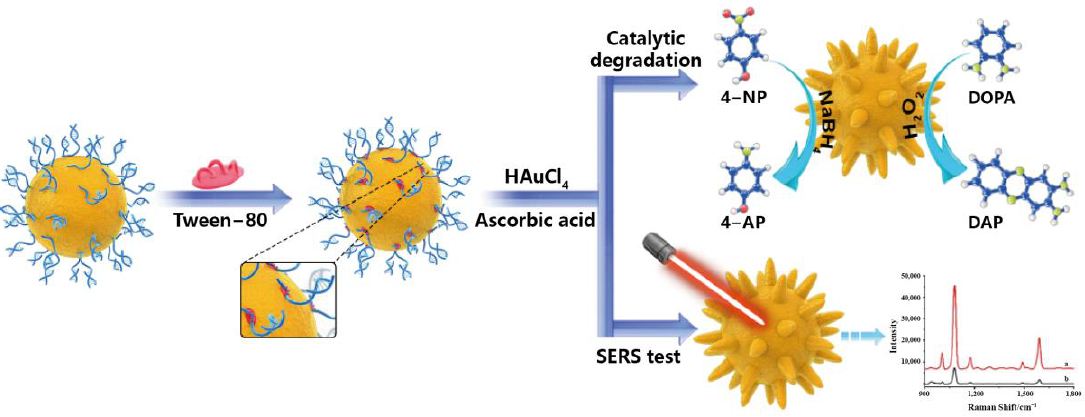
Figure 3. Schematic of the synthesis of sea urchin-shaped AuNCs for SERS analysis and catalytic degradation. Reprinted with permission from [39]. Copyright 2021 IOP Publishing Ltd. Printed in the UK.